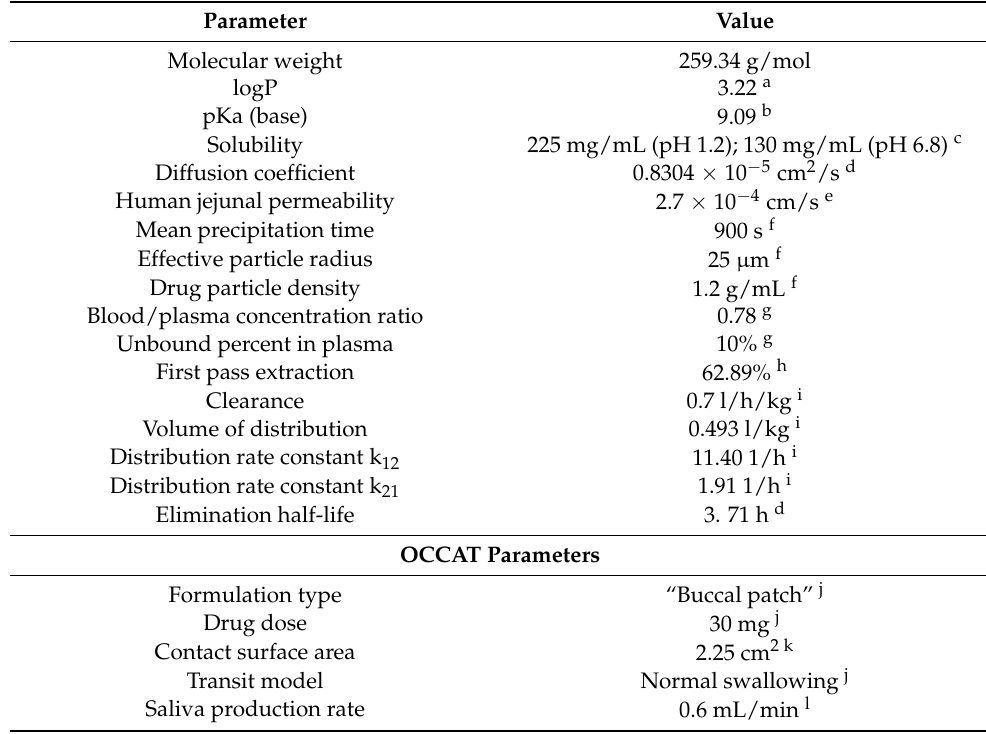
Table 1. Model input parameters.